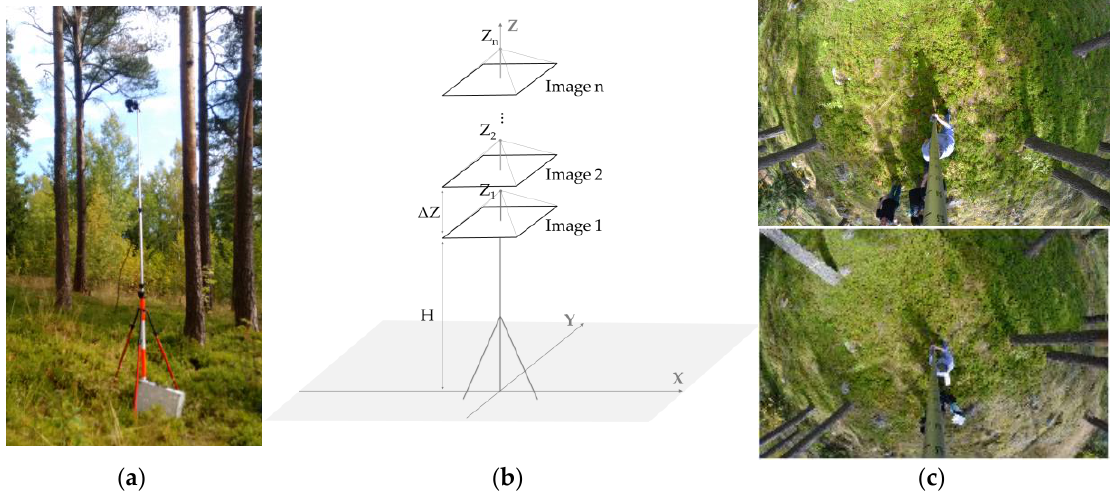
Figure 2. ( a ) Fisheye camera positioned in the nadir viewing position to collect images; ( b ) Camera displacement (ΔZ) for acquisition of a vertical image sequence ( n ); ( c ) Fisheye images in the nadir viewing position (first and last images in the sequence). Table 1. Technical features of the fisheye camera.